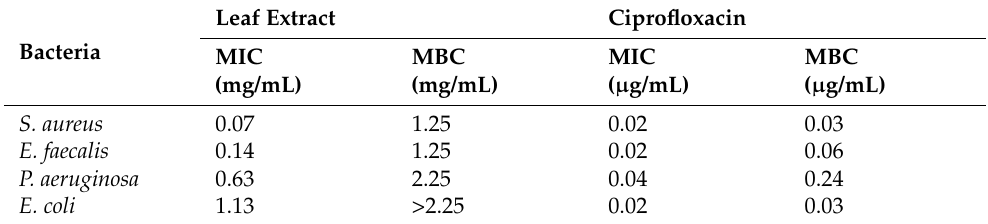
Table 3. MIC and MBC of the whole leaf extract of A. arborescens Mill.